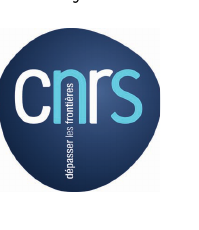
profiles are coarsely